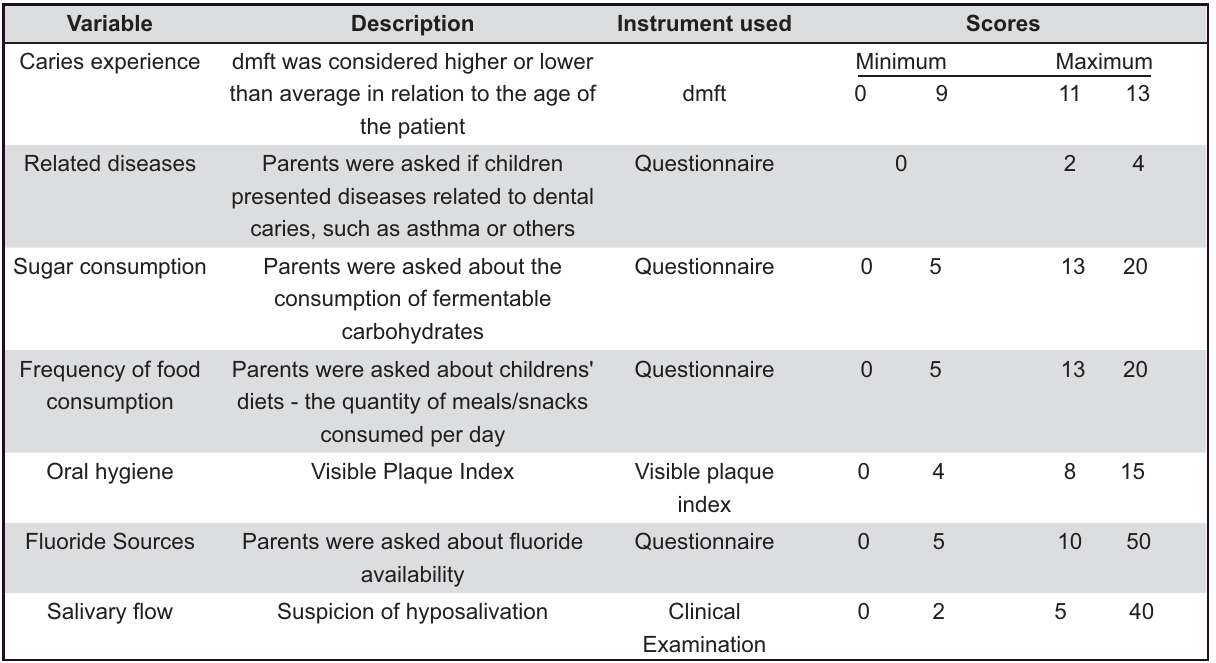
Figure 2- Variables assessed, their description, the instrument used and the scores of each variable according to